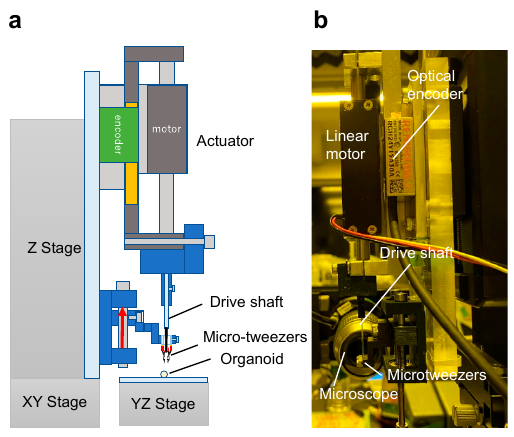
Figure 3. Developed actuation system for micro-tweezers using a linear motor. ( a ) Schematic of the developed system; ( b ) photo of the developed system with microscope for the observation of micro-tweezers’ motion.